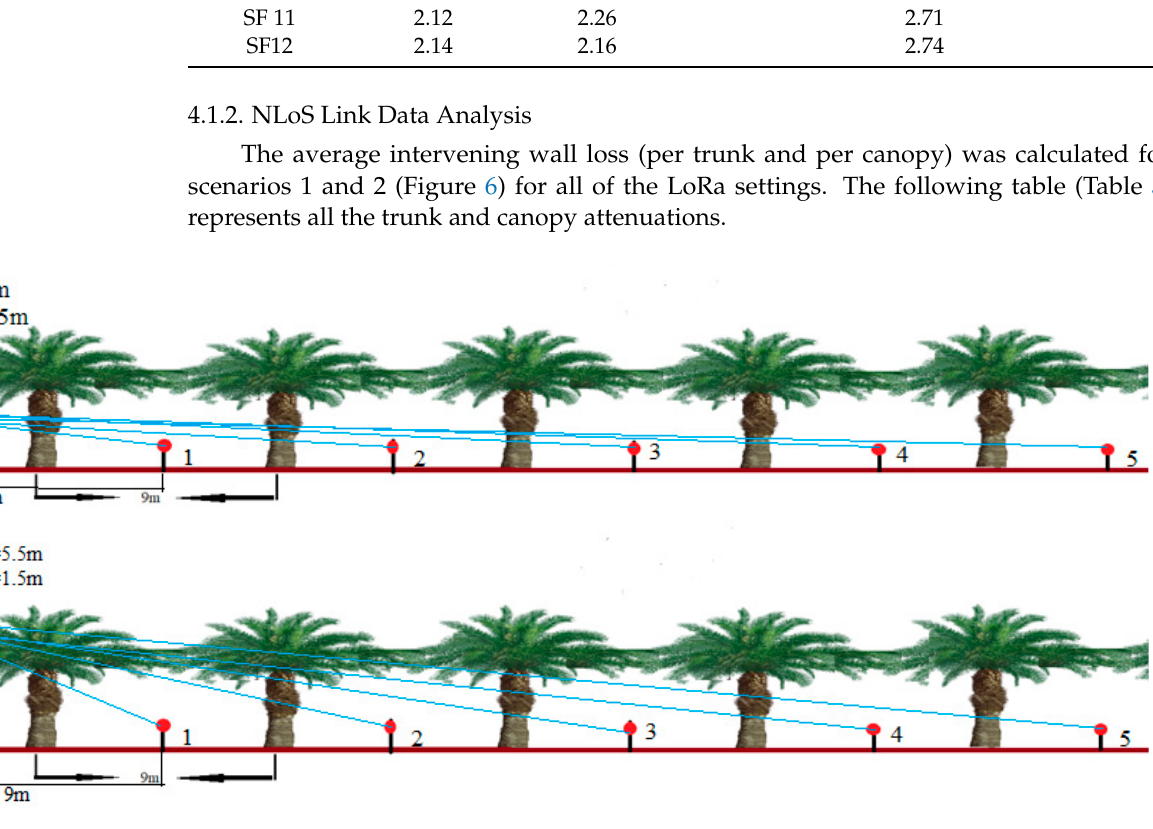
Figure 6. Scenario 1: propagation through the trunks ( above ); Scenario 2: propagation through the canopy ( below ). Table 5. Trunk and canopy attenuation.